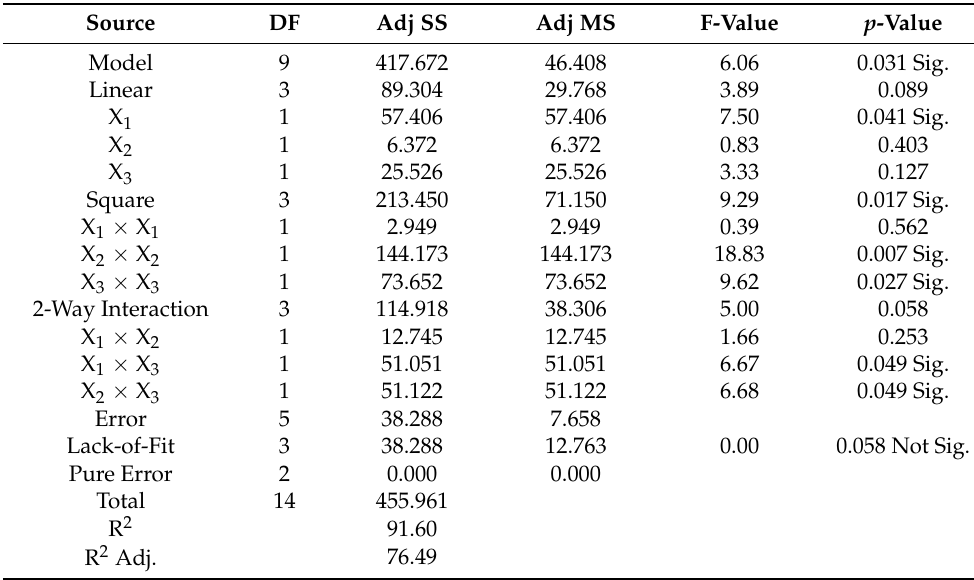
Table 7. ANOVA for response surface quadratic model on salinity